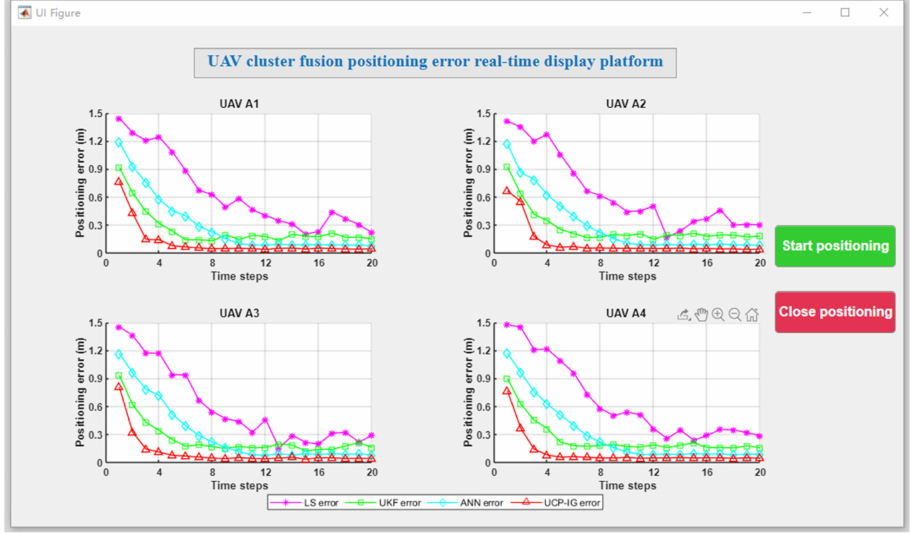
Figure 7. GUI positioning error display platform (comprehensive